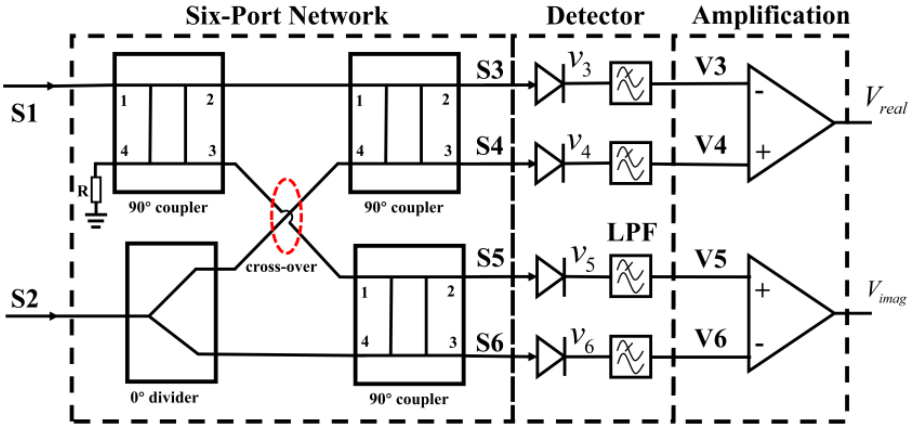
Figure 1. The typical block diagram of add-and-square analog correlator.